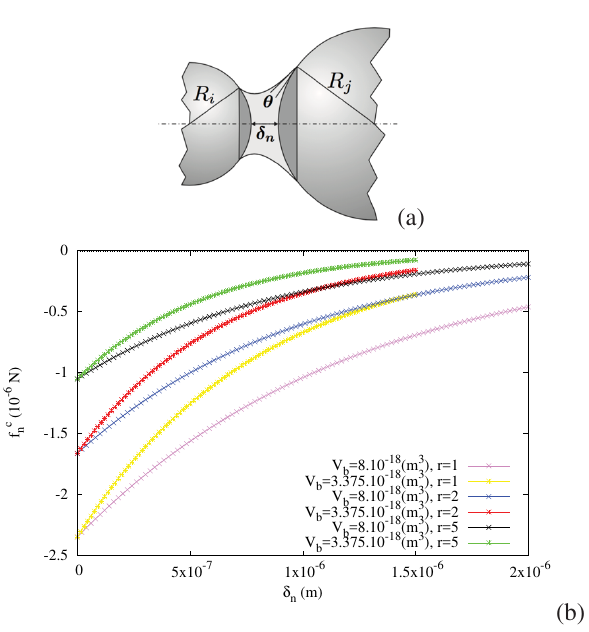
Figure 1. Geometry of the capillary bridge (a) and capillary force f c for di ff erent values of parameters as a function of the n gap δ n , liquid volume V b and size ratio (b).